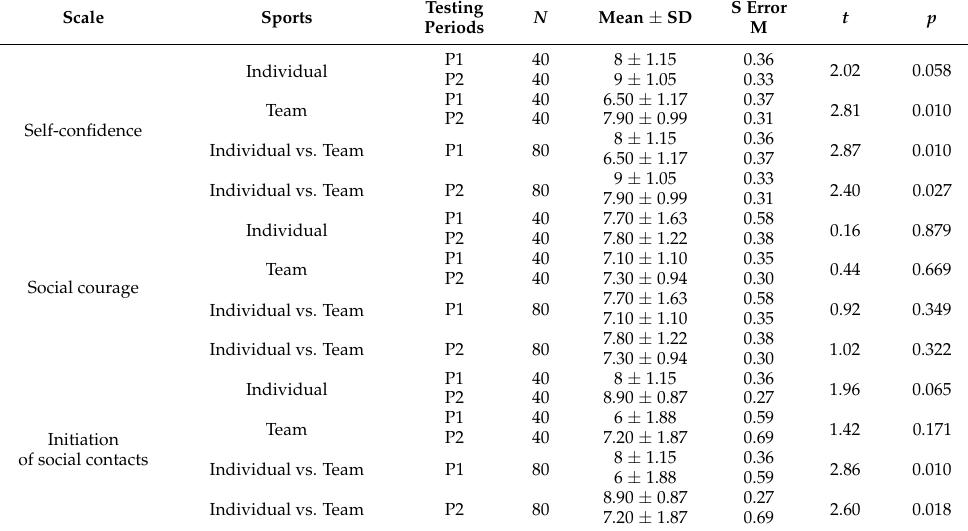
Table 2. The results obtained in the Self-Confidence